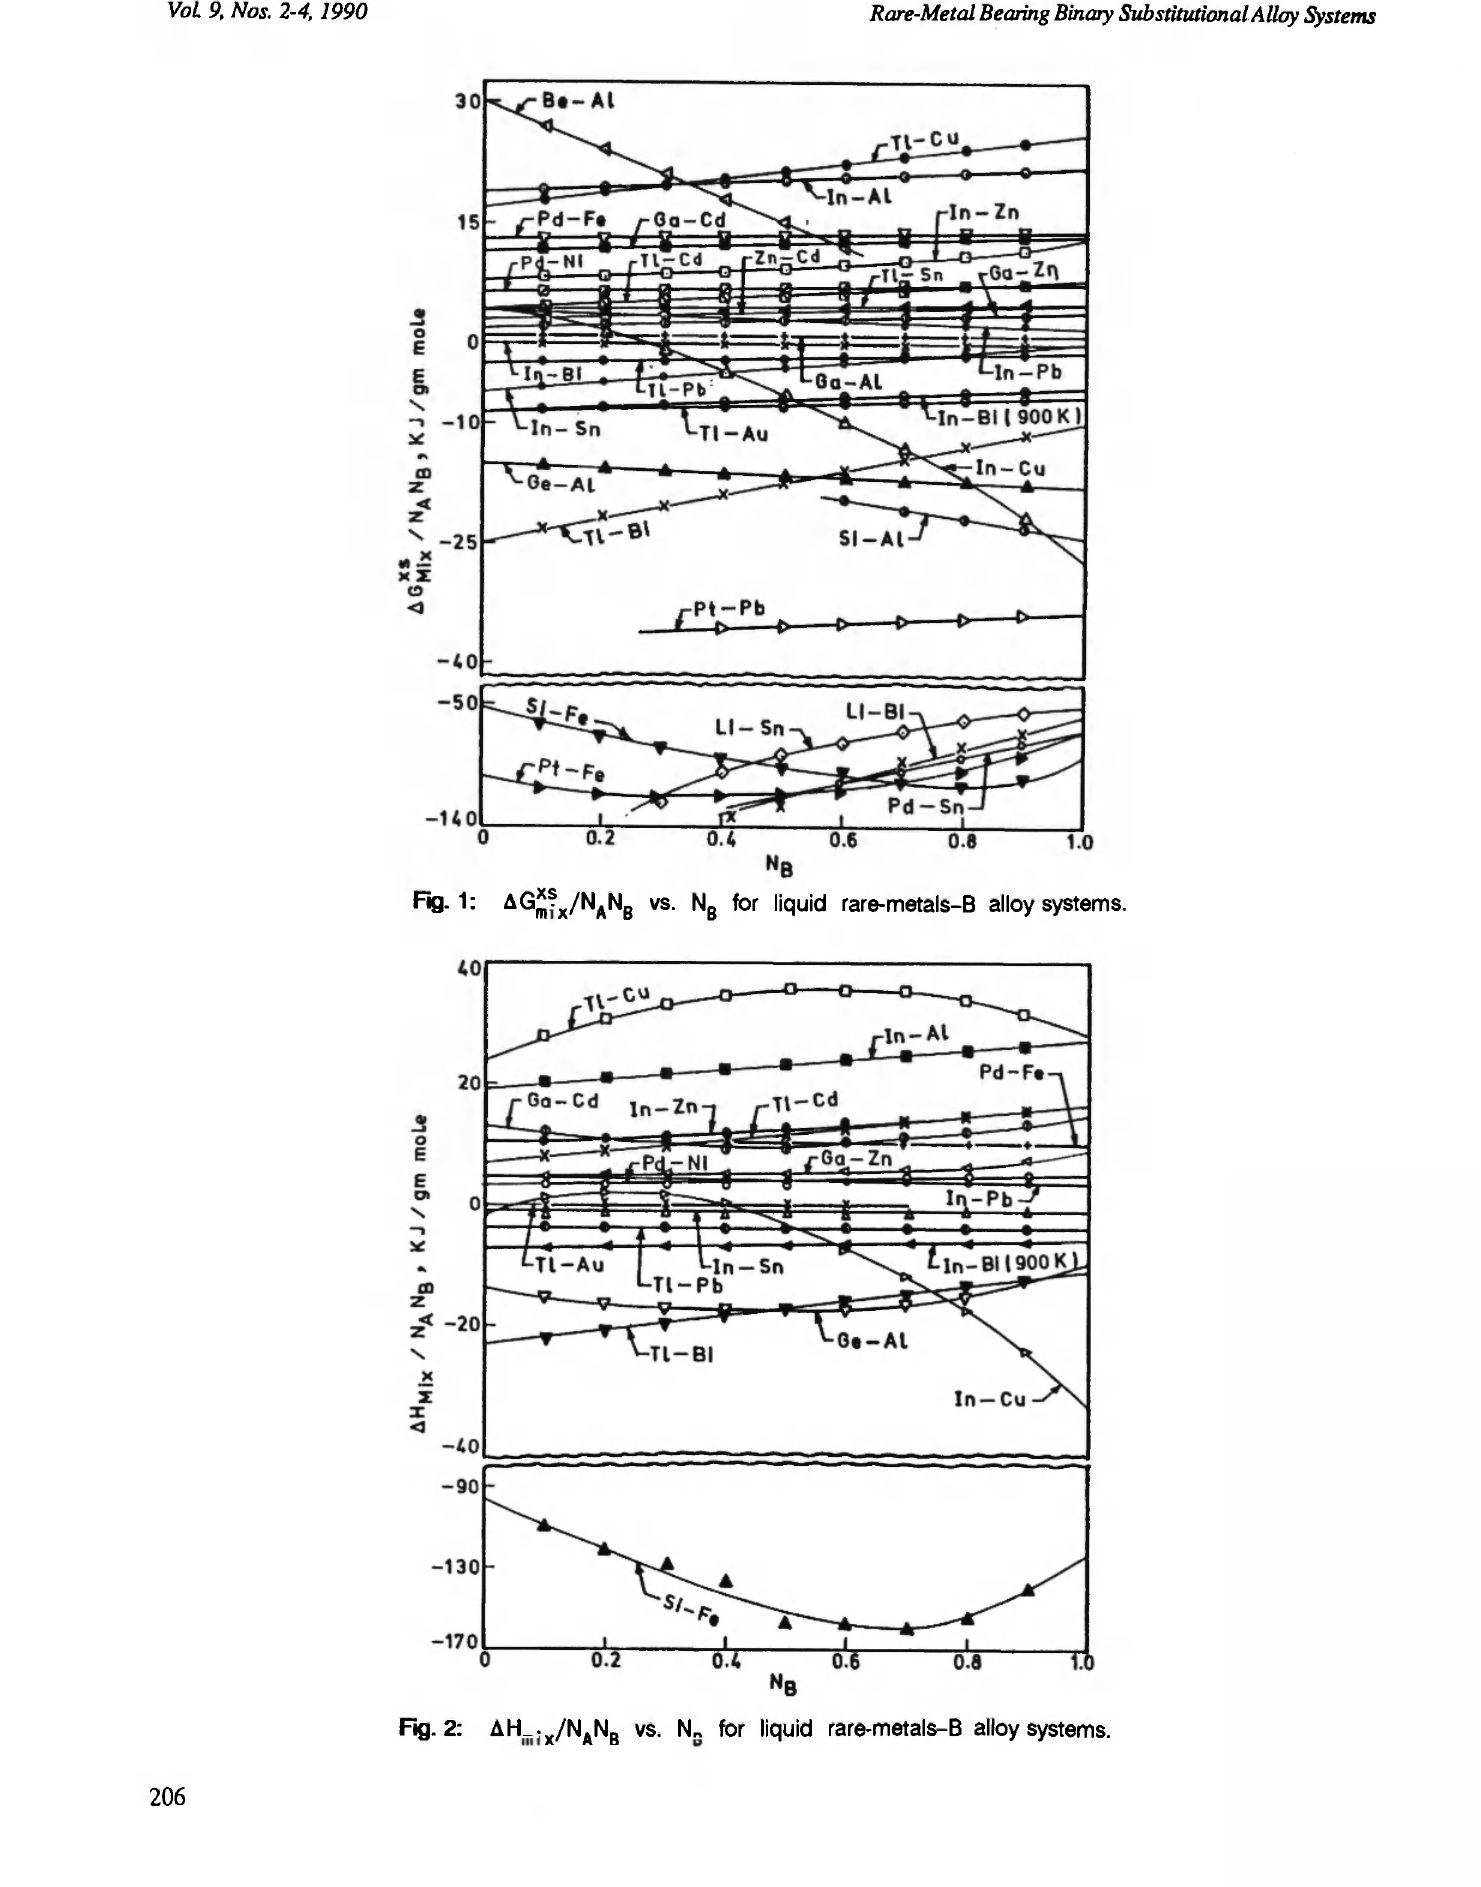
Fig. 2: AH - X /N A N B vs. N„ for liquid rare-metals-B alloy